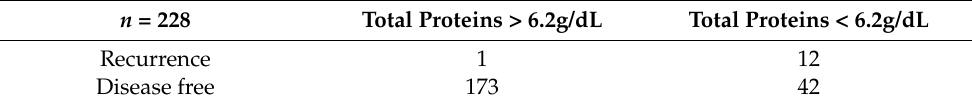
Table 5. Distribution of patients with recurrence depending on total protein levels two years after surgery.